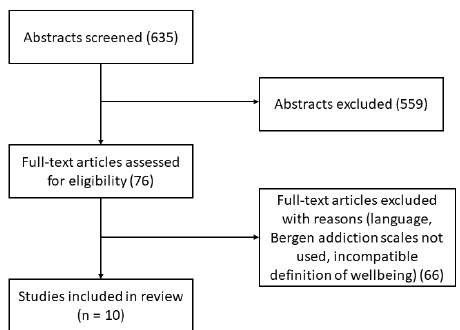
Figure 1. Diagram showing the flow of information through the review: the number of records identified, included and excluded, and the reasons for the exclusions.